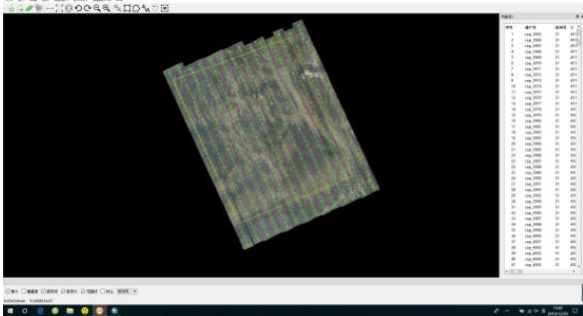
Figure 11. Quick quality inspection of aerial image